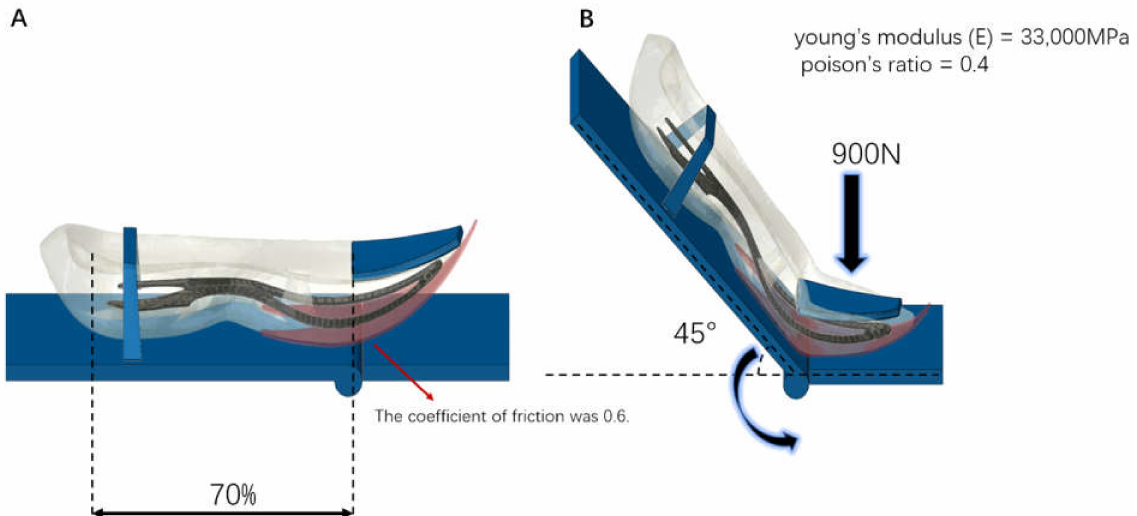
Figure 2. Showed the finite element simulation ( A ): The initial position, ( B ): Conditions imposed by finite element